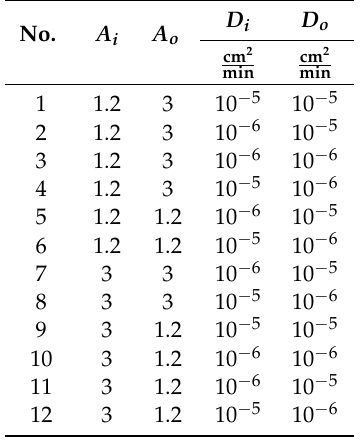
Table 2. Retention ( A i and A o , see. Equations (11) and (12)) and pore diffusion parameters ( D i and D o ) of the inner and outer layers used for the calculation of separation efficiencies of superficially porous bi-layer